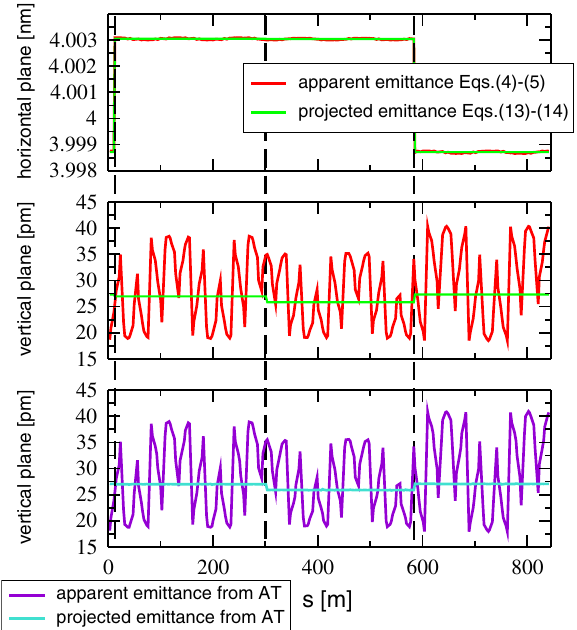
FIG. 1. Example of RMS apparent and projected emittances plotted along the ESRF storage ring. Betatron coupling is driven by three skew quadrupoles whose location is indicated by the vertical dashed lines. In the top and center plots, the horizontal and vertical emittances are evaluated via Eqs. (4), (5), (13), and (14). The bottom plot shows the results for the vertical plane as computed by AT . The corresponding equilibrium emittances are E ¼ 4 : 0 nm and E ¼ 18 : 4 pm u v